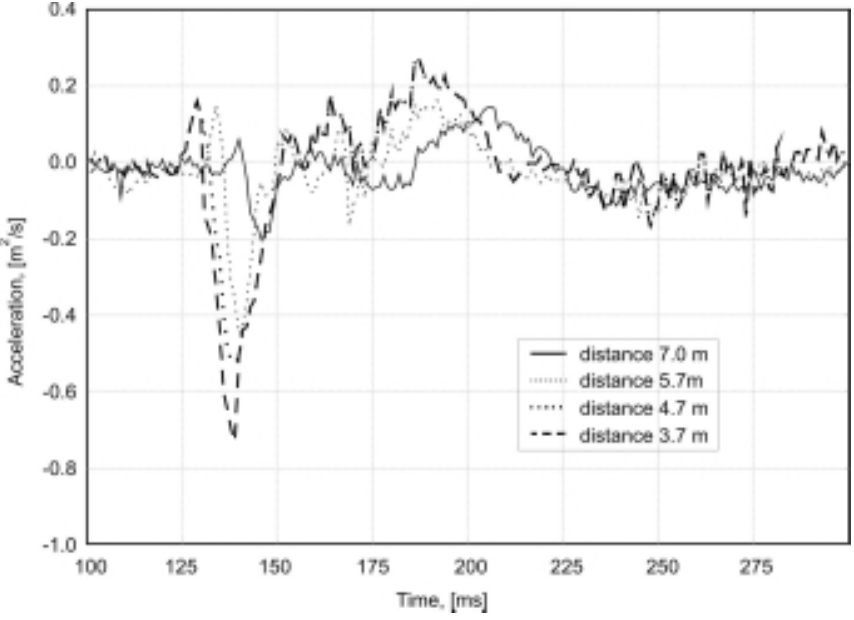
Fig. 27. Time histories of structure acceleration depend on detonation distance charge-silo with barrier.